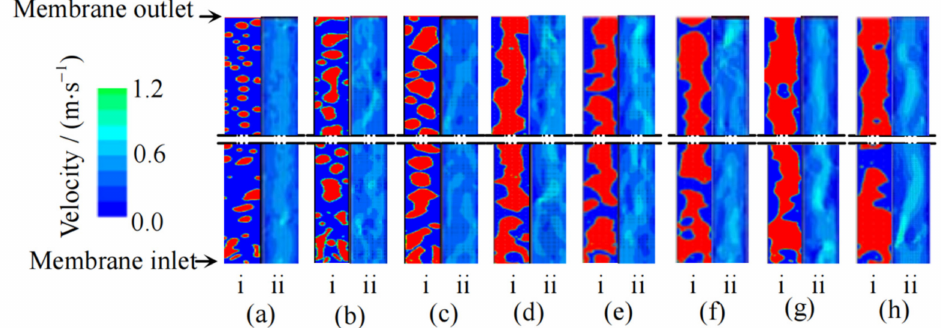
Figure 8. Effects of gas holdup on flow pattern and velocity [18]. Reproduced with permission from Higher Education Press, 2019. Gas holdup: ( a ) 0.20; ( b ) 0.33; ( c ) 0.43; ( d ) 0.50; ( e ) 0.56; ( f ) 0.60; ( g ) 0.64; ( h ) 0.67. (i). Transient flow pattern (red/light-gas phase; blue/dark-liquid phase); (ii). Velocity.